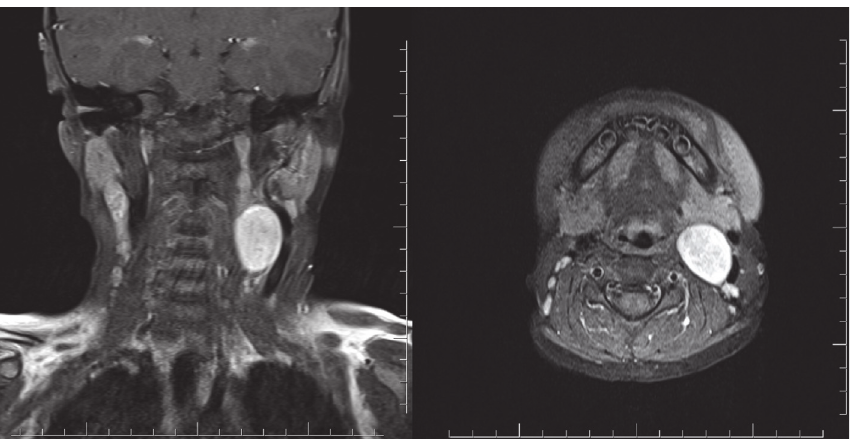
Figure 1: MRI of the head and neck: axial and coronal views of mass. The lesion with 2 , 8 ∗ 2 , 3 cm size on the front of musculus sternocleidomastoideus and internal carotid